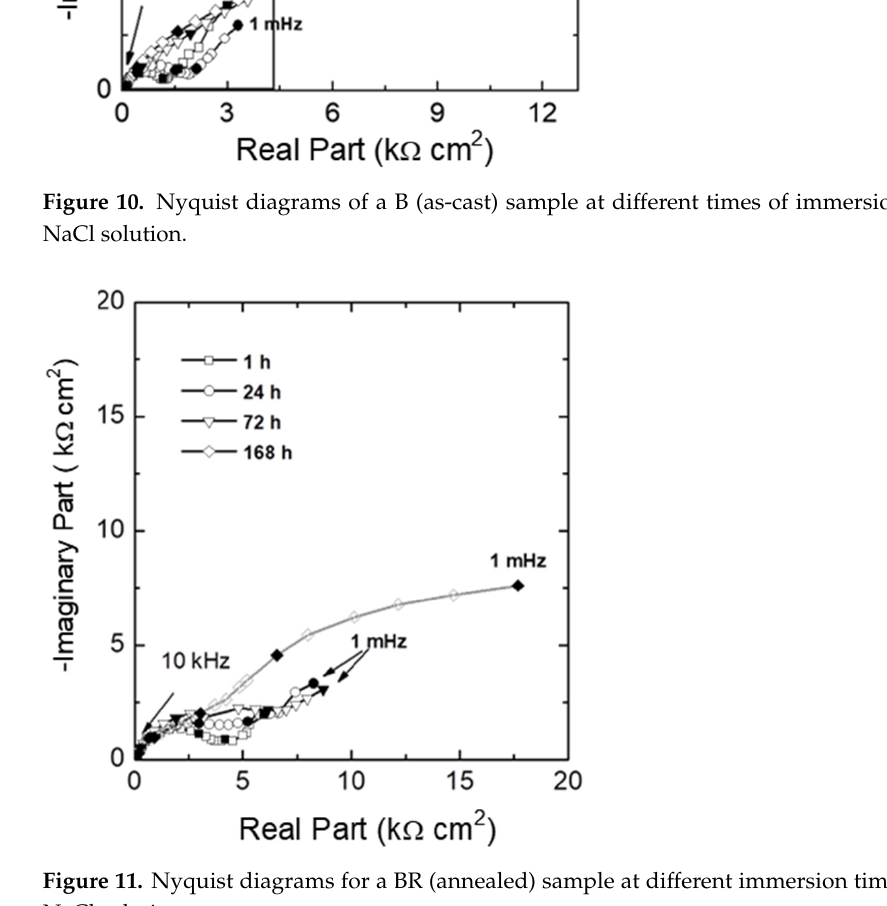
Figure 11. Nyquist diagrams for a BR (annealed) sample at different immersion times in 3.5 wt.% NaCl solution.